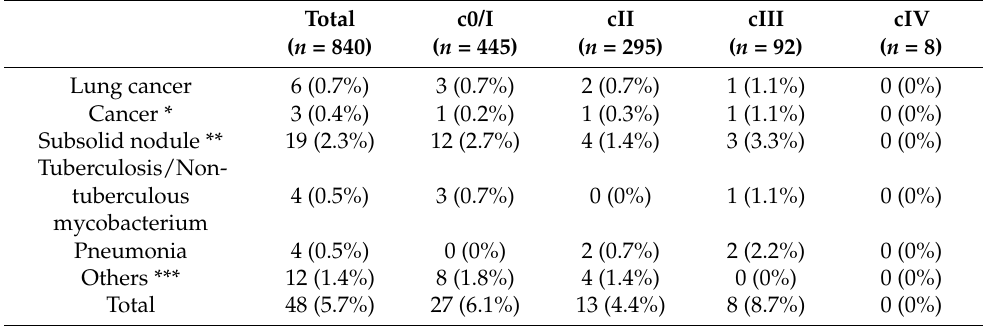
Table 7. Ancillary findings at staging contrast-enhanced chest